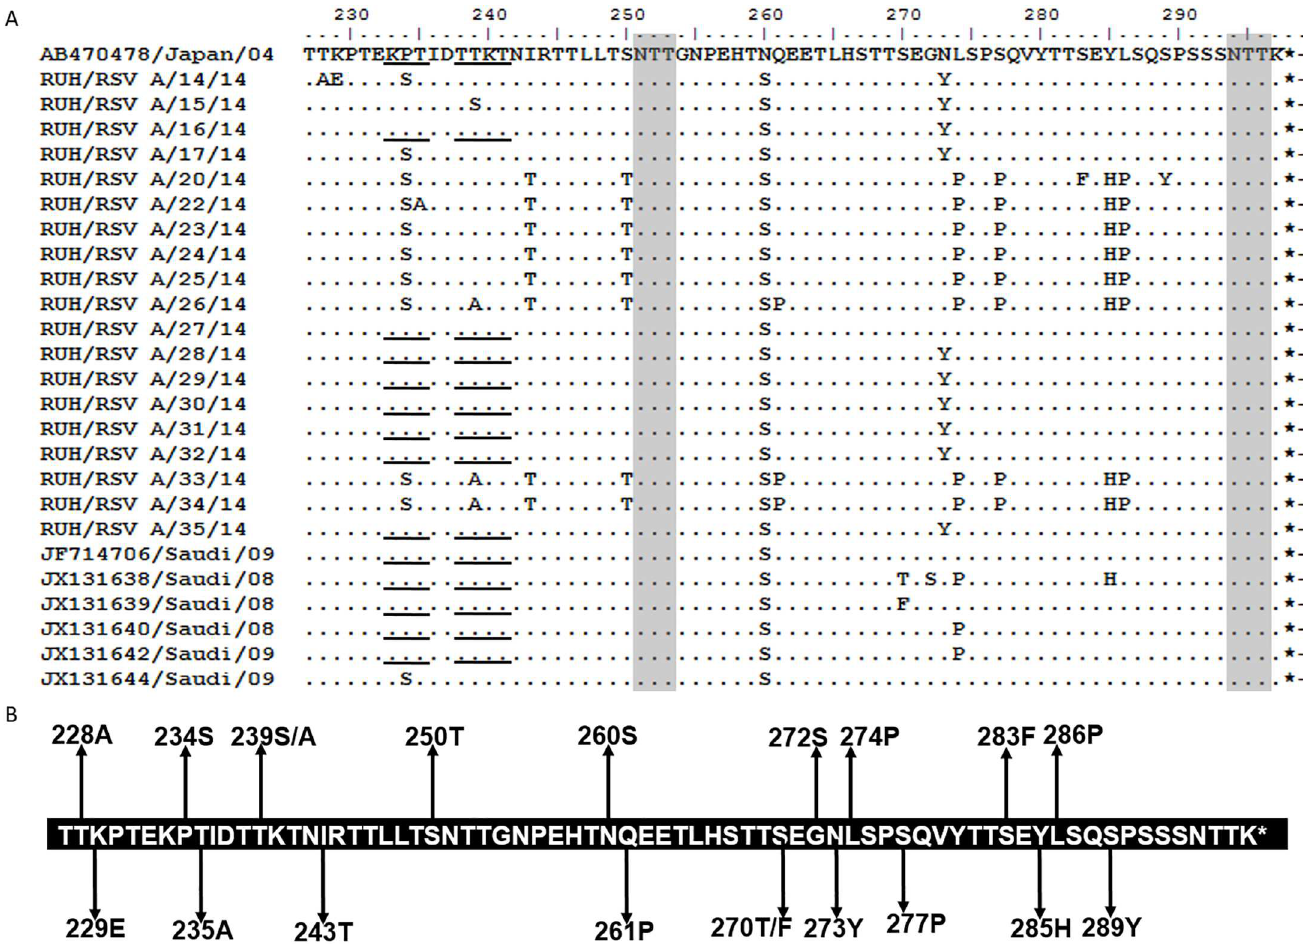
Fig 2. (A) Deduced amino acid alignment and mutations in the second hyper-variable region of G protein of the NA1 genotype. The figure includesalignment of Saudi NA1 strains with the prototypestrain from Japan(AB470478). The amino acids sequencealignment corresponds to 227–297 amino acids of the prototypestrain. Identicalresidues are indicatedby dashes. Stop codons are indicatedby asterisks. Potential N-glycosylation sites (NXT, where X is not proline)are indicatedby grey shading. The potentialsites for extensive O-glycosylation KPX - - - TTKX motifs are underlined. (B) The amino acid sequence of NA1 genotype showing mutations in the Saudi strains. The sequencecorrespondsto the 227–297amino acids of the NA1 prototypestrain. Changesat amino acid positionsin Saudi strains are shown by arrows.